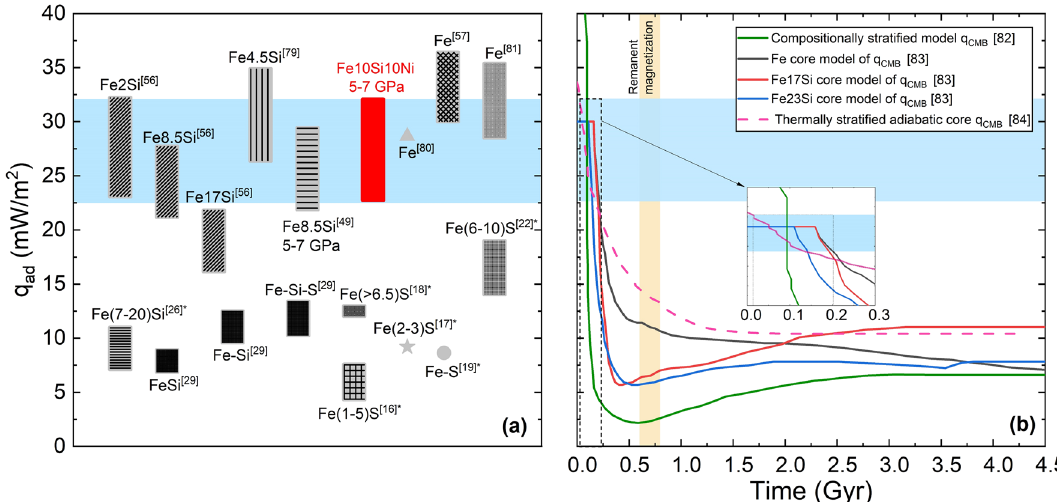
Figure 5. ( a ) The adiabatic heat flux density at the top of Mercury’s core compared to values calculated from other studies in the literature 16–19,22,26,29,49,56,57,79–81 . The compositions are in wt%. The results from this study are in red and extended to the blue shaded area. The * denotes theoretical studies. ( b ) Thermal evolution models of the heat flow through Mercury’s core-mantle boundary as a function of time since planet formation at 0 Gyr 82–84 . The intersection of the results from this study with the range of thermal evolution models is marked by the dotted rectangle and expanded in the inset plot. The remanent magnetization suggests the latest time interval during which a dynamo was active is represented by the orange shaded area 85–89